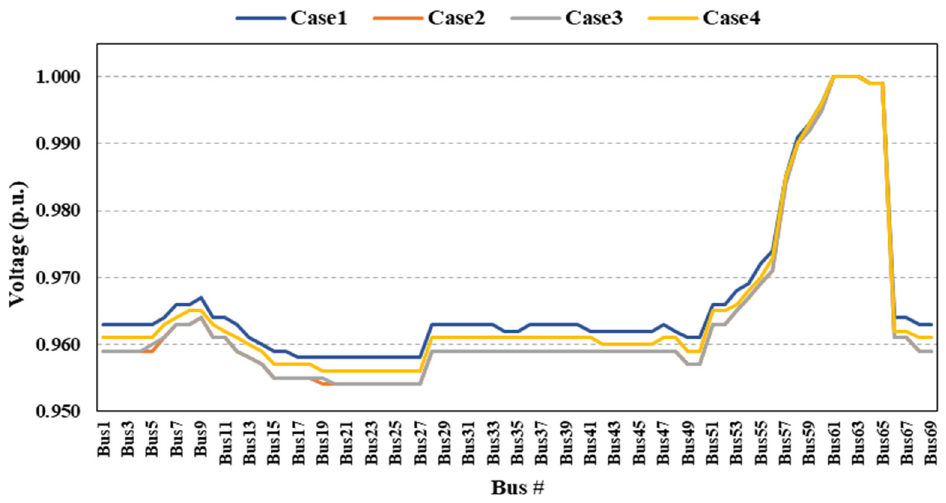
Figure 12. The observed efficiency (%), under-utilization (MVA), power losses (MW), and function F values in four cases for the 69-bus autonomous distribution network.